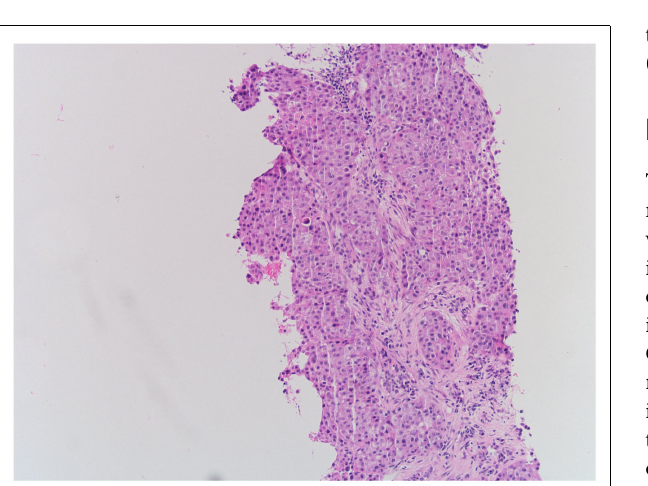
systemic therapy (nivolumab) but passed away from supraventric- ular tachycardia, which progressed to pulseless cardiac